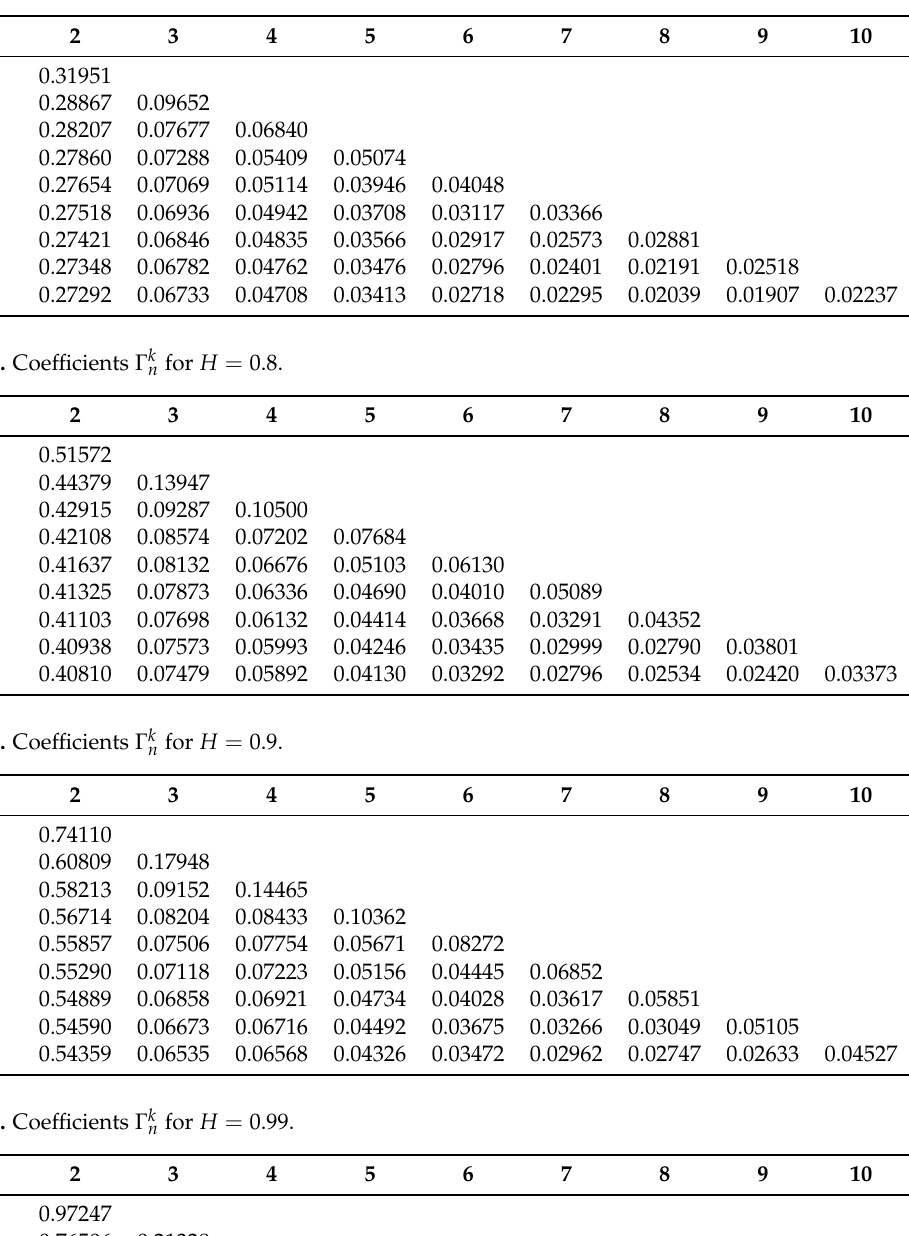
Table 3. Coefficients Γ k n for H = 0.7.